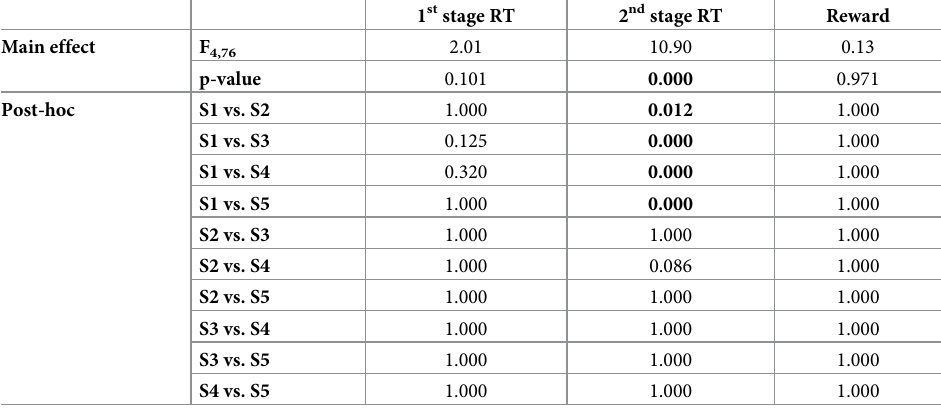
Table 1. Response times and reward rates. Repeated measures ANOVA assessing training effects on response times (RT) and reward rates. Significant results on an alpha level p < 0.05 are highlighted (bold). See Fig 3 for illustration. 1 st stage